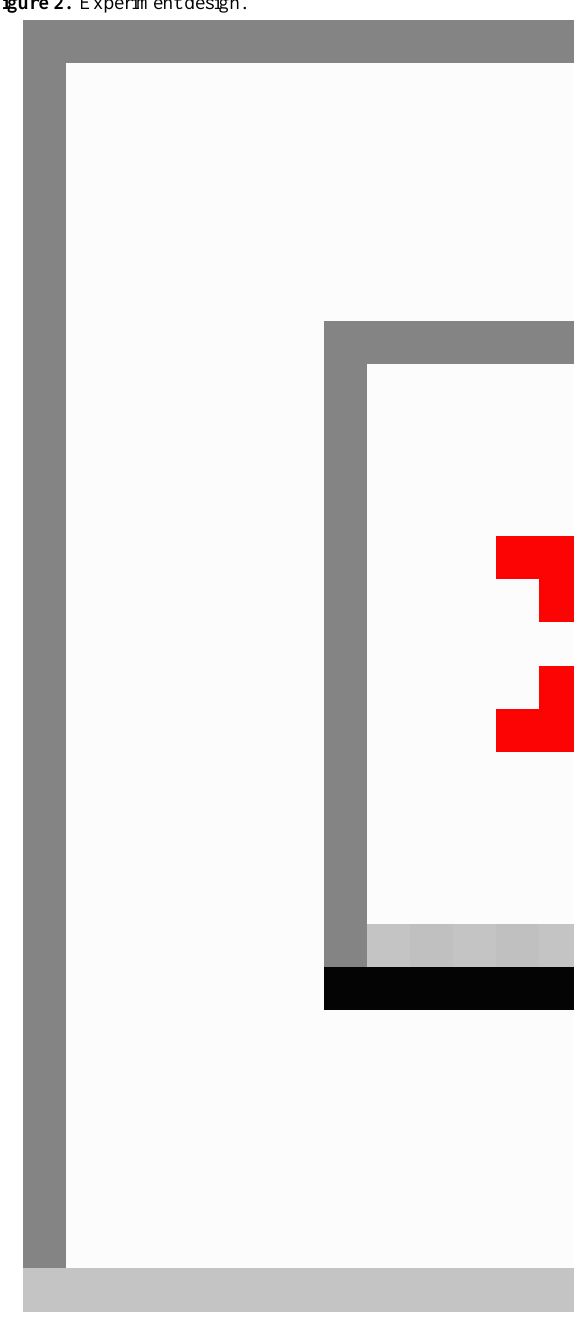
Figure 2. Experiment